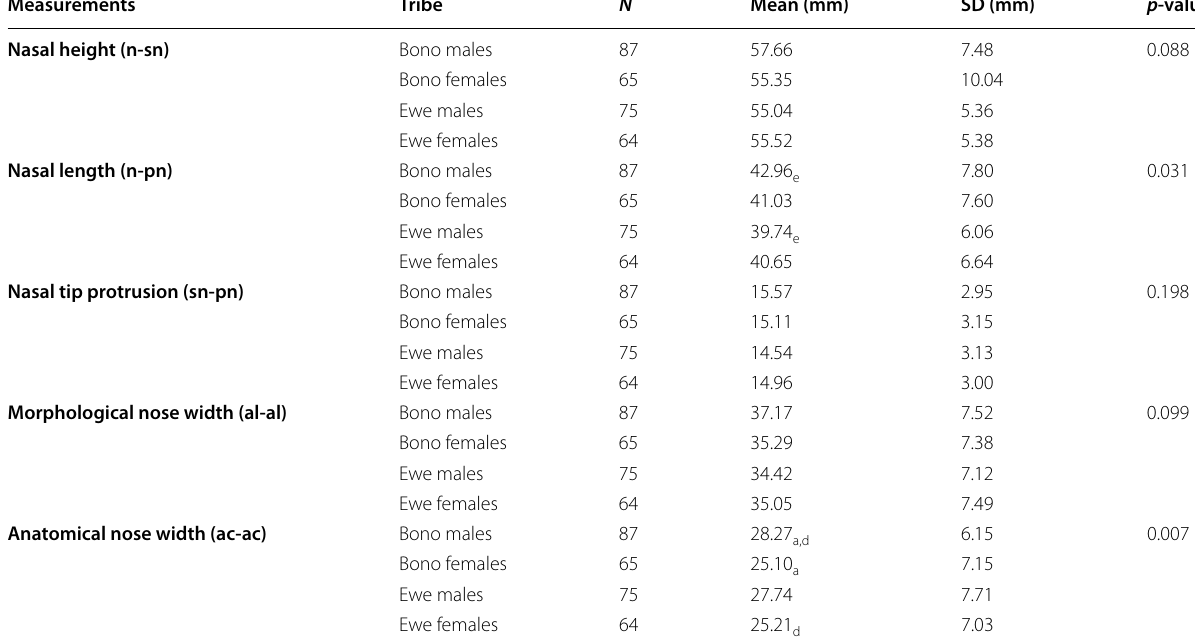
Table 4 Analysis of variance (ANOVA) of nasal measurements of Bono and Ewe participants